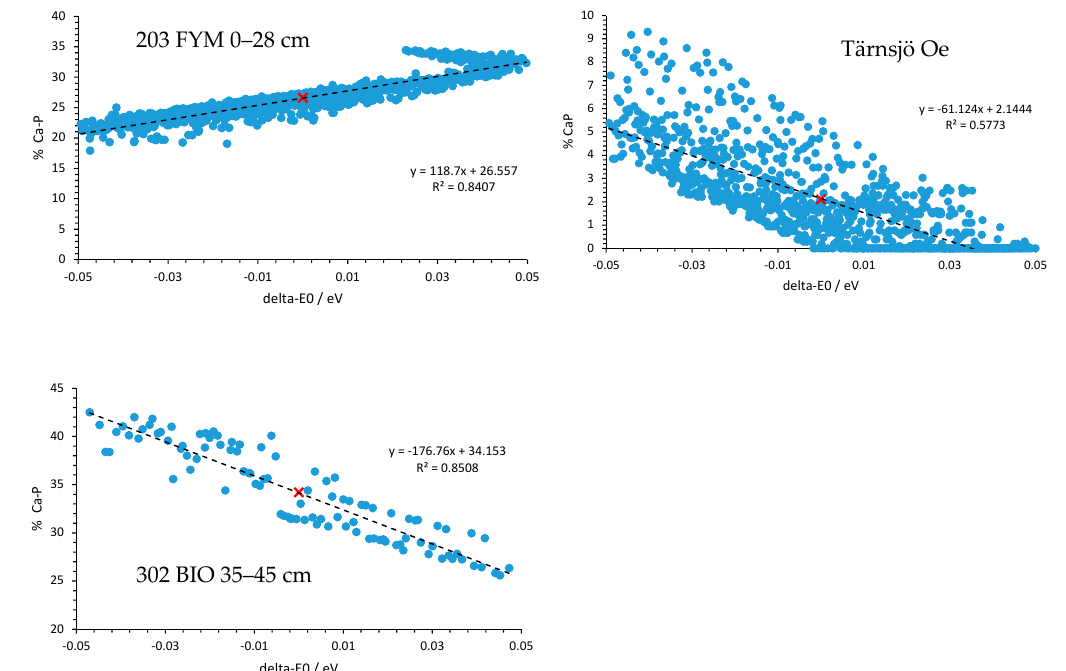
Figure 4. LCF-fitted percentage of Ca phosphates as a function of the error in calibrated energy ( ∆ E 0 ) for three different soils. For 203 FYM 0–28 cm and Tärnsjö Oe, 1000 data points were sampled, whereas the figure for 302 BIO 35–45 cm is based on 100 data points. The cross denotes the mean value as reported in Table 3.